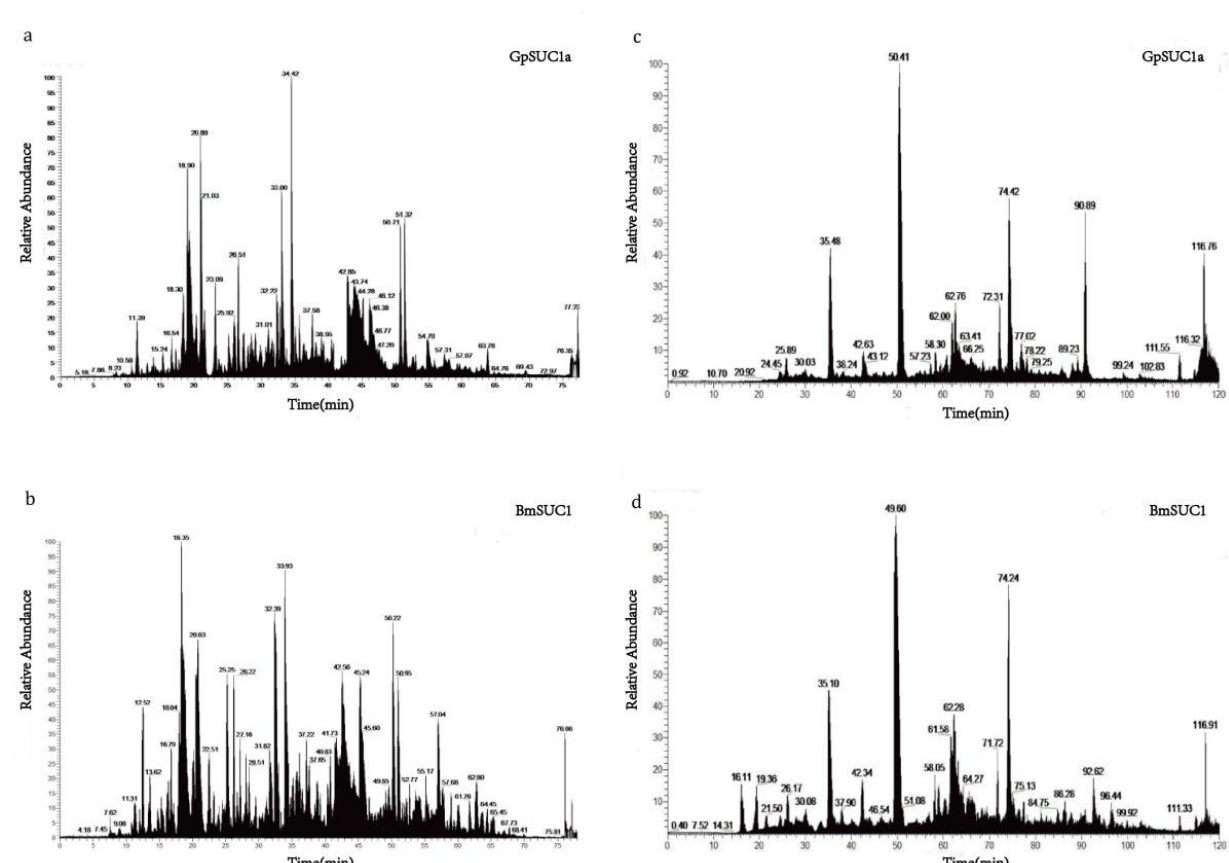
Figure 5. More posttranslational modifications in BmSUC1 than in GpSUC1a. The samples of BmSUC1 and GpSUC1a degradation products were separated by the Easy nLC 1000 system. ( a ) Liquid Mass spectra of GpSUC1a about N-glycosylation and methylation. ( b ) Mass spectra of BmSUC1 about N-glycosylation and methylation. LC-MS results of GpSuc1a and BmSUC1 about phosphorylation, acetylation, and ubiquitination ( c , d ).